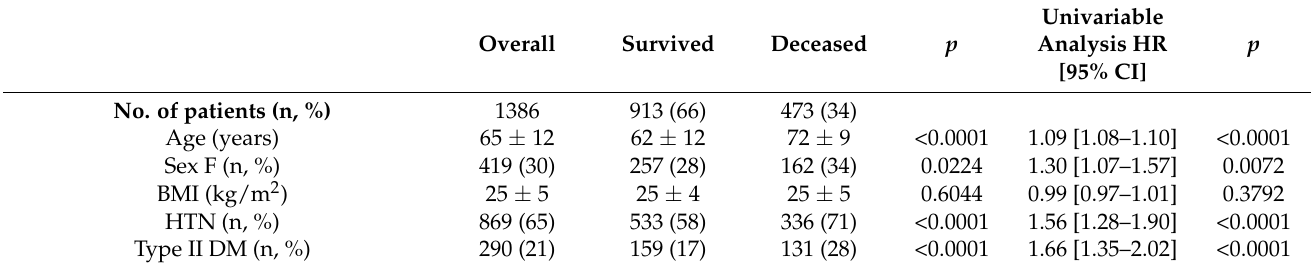
Table 1. Demographic and clinical features of the investigated surgical patient population.